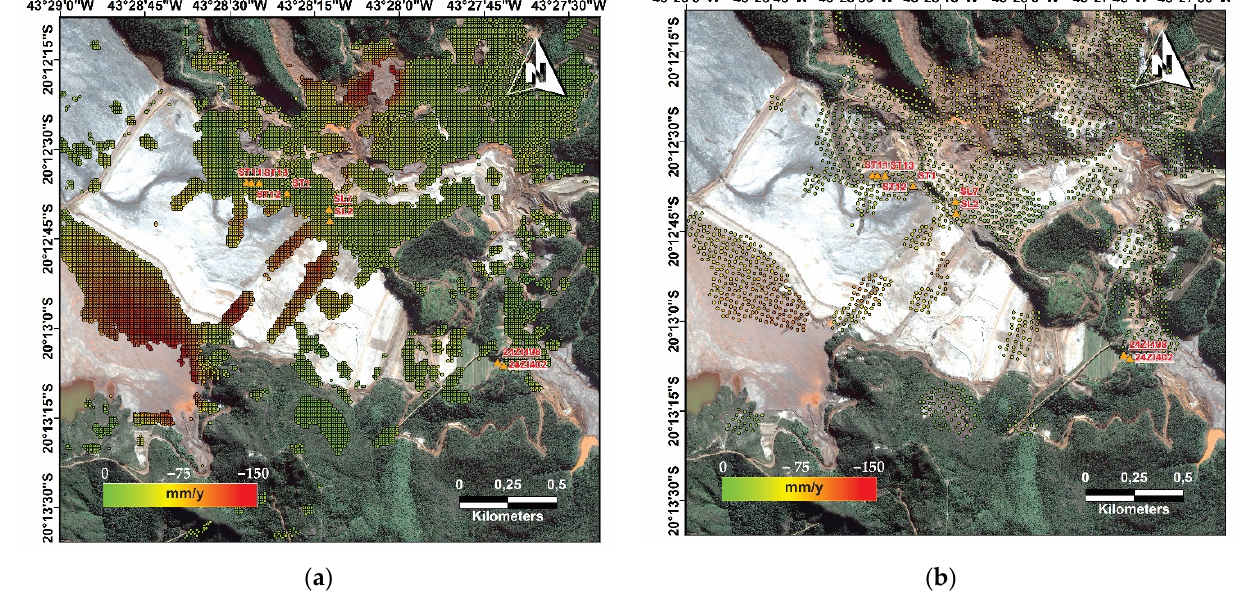
Figure 6. Velocity displacement map in LoS: ( a ) TSX data, ( b ) S1B data. The orange triangles represent the position of the prims used for the topographic surveying.